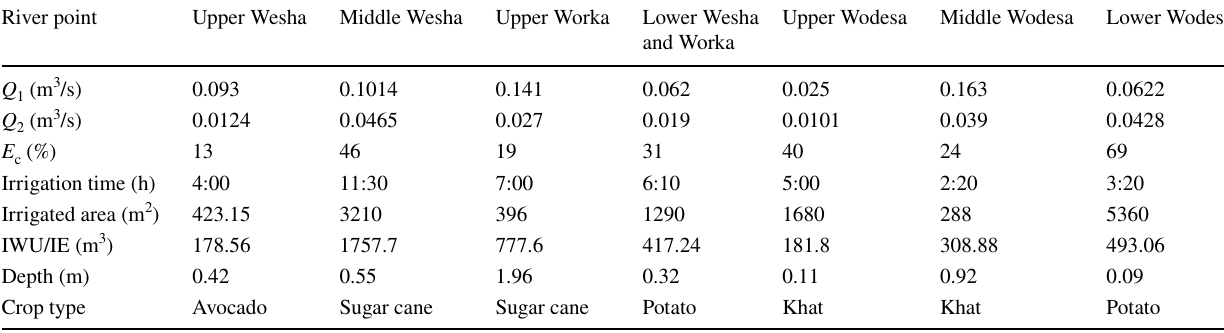
Table 3 Estimated discharge and conveyance efficiency on farmers’ field in Cheleleka watershed, Ethiopia